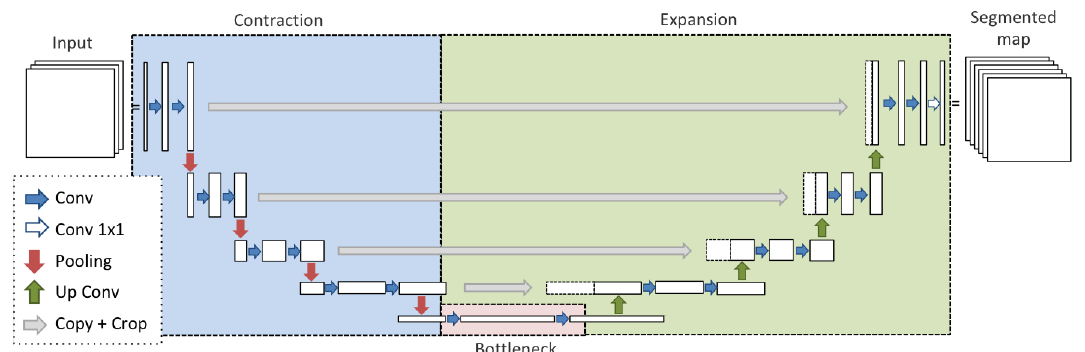
Figure 8. The general schema of a residual block with the skip or identity connection. The skip connection let the training process bypass learning the inner weight layers (of convolutions with/without pooling) parameters.